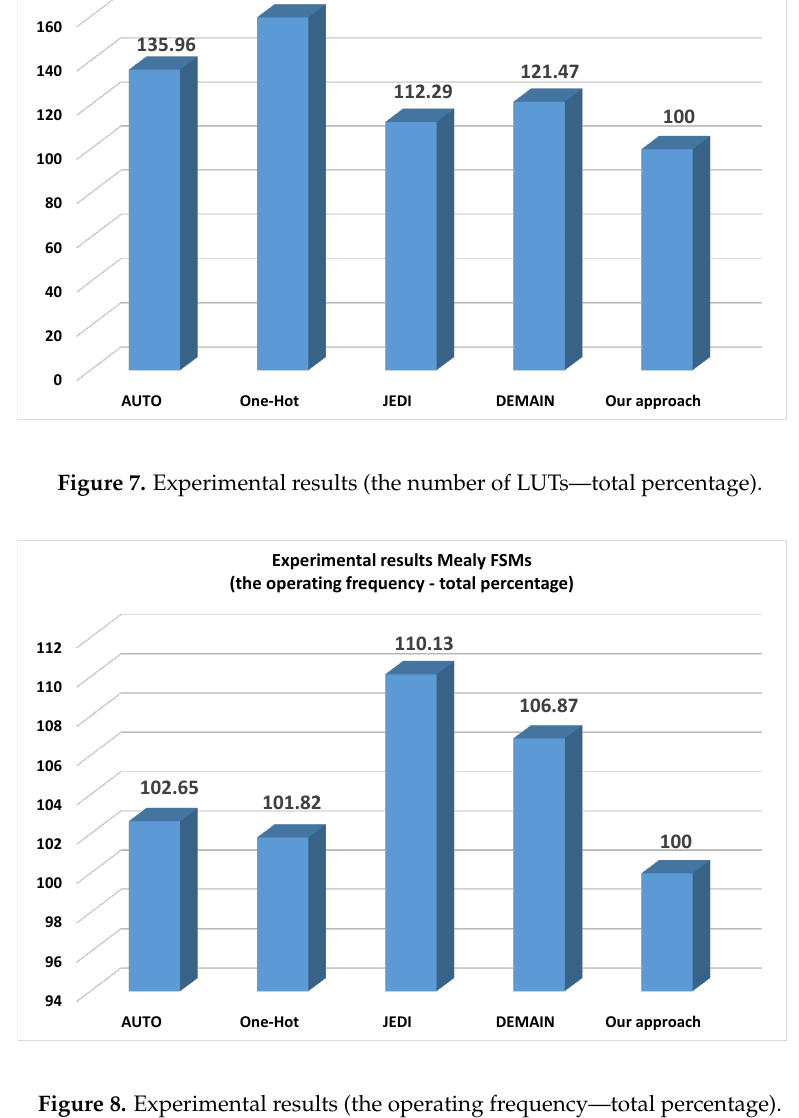
Figure 8. Experimental results (the operating frequency—total